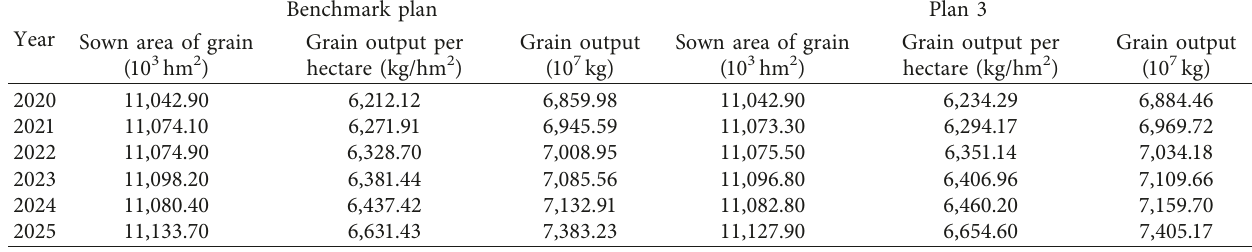
Table 8: Comparison of simulation results between Benchmark plan and Plan